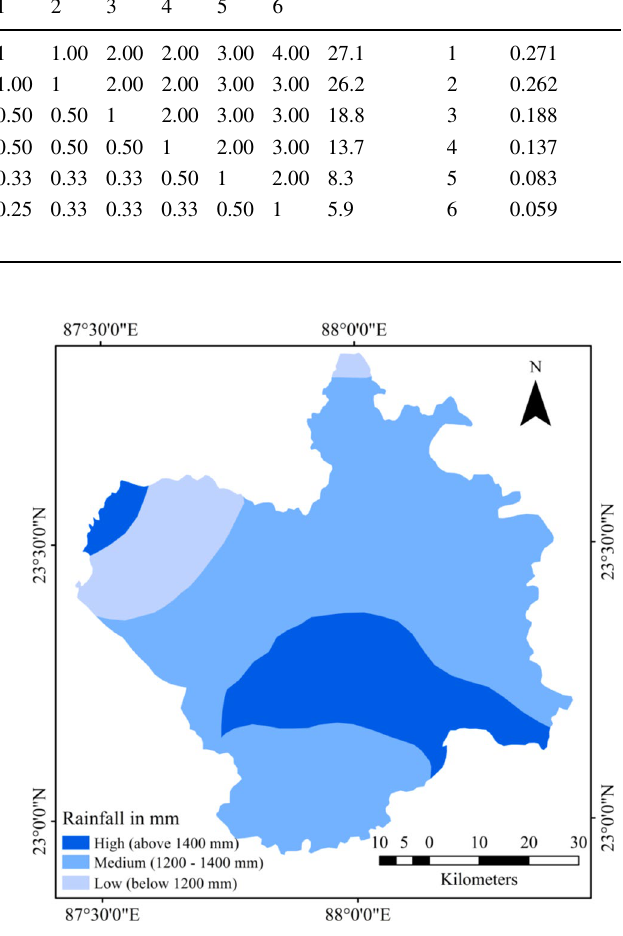
Table 4 Pair-wise comparison matrix for AHP and priority and rank of themes